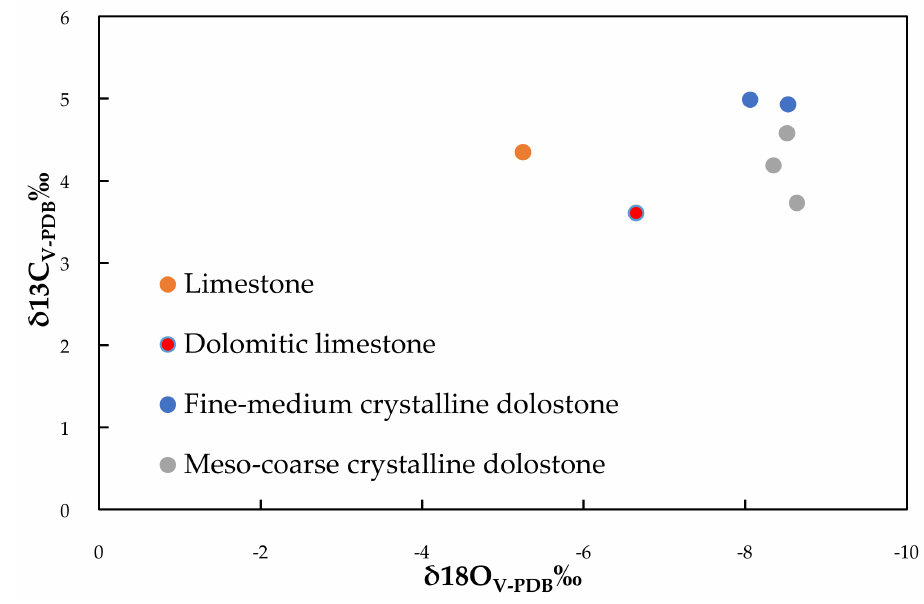
Figure 8. Cross plot of carbon and oxygen